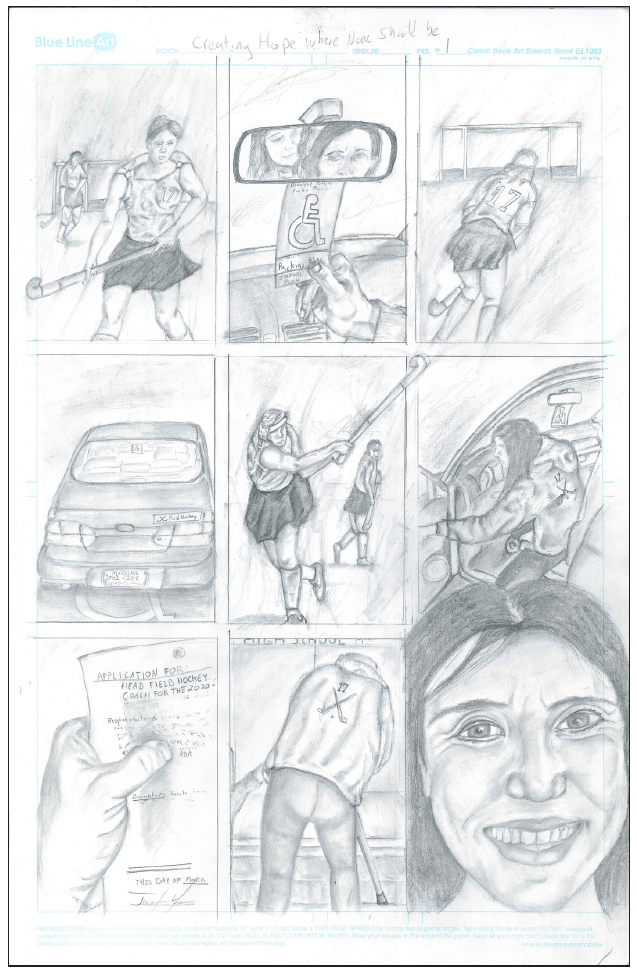
Figure 1: Creating Hope Where None Should Be. This is the author’s attempt to create a graphic narrative and use this narrative as a means of political